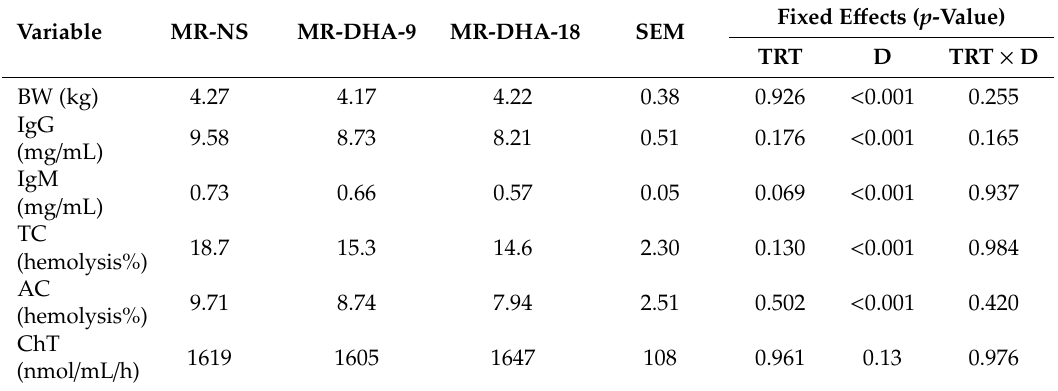
Table3. Leastsquaresmeansofbodyweight(BW),immunoglobulinG(IgG)andM(IgM)concentrations, chitotriosidase (ChT) activity as well as total complement (TC) system and alternative pathway (AC)